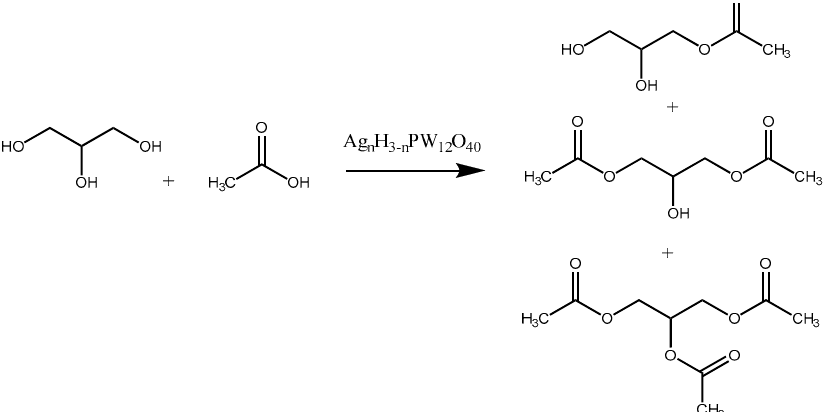
Scheme 2. Main products of the Ag n H 3-n PW 12 O 40 -catalyzed glycerol esterification with acetic [54]. acid [54].